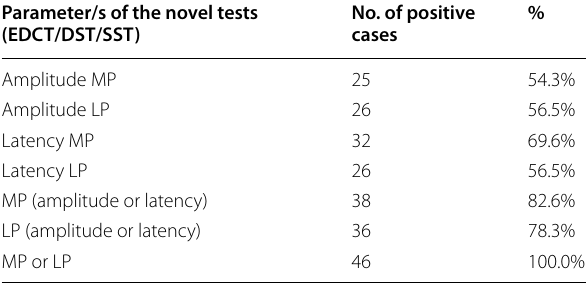
EDCT Eversion dorsiflexion compression test, DST Double stance test, SST Single stance test, MP Medial plantar, LP Lateral plantar